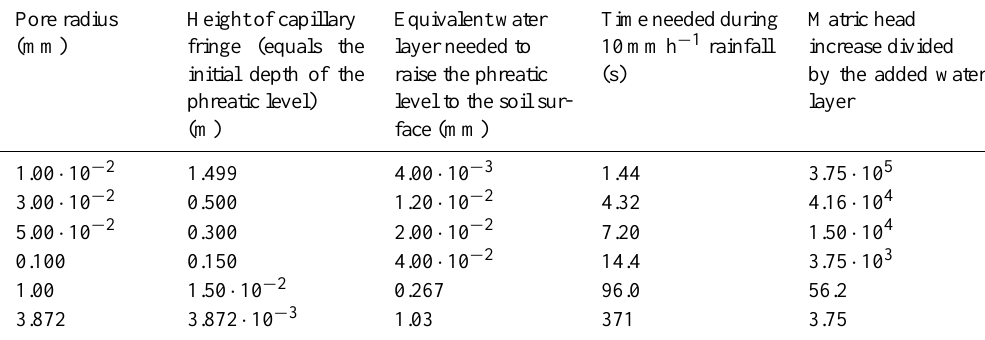
Table 1. Amount of water needed to bring the phreatic level up to the soil surface when initially the capillary fringe extends to the soil surface, and the time needed to deliver this water during rainfall of moderate intensity. The soils are assumed to have cylindrical pores of uniform radius. The soil water is 15 ◦ C (with corresponding density and air-water surface tension), and the gravitational acceleration is 9.812ms − 2 . For the third column, a porosity of 0.60 is assumed for pores ≤ 0.1mm, and of 0.40 for larger pores. Note that the last row gives the limiting radius where the capillary rise equals the pore radius.